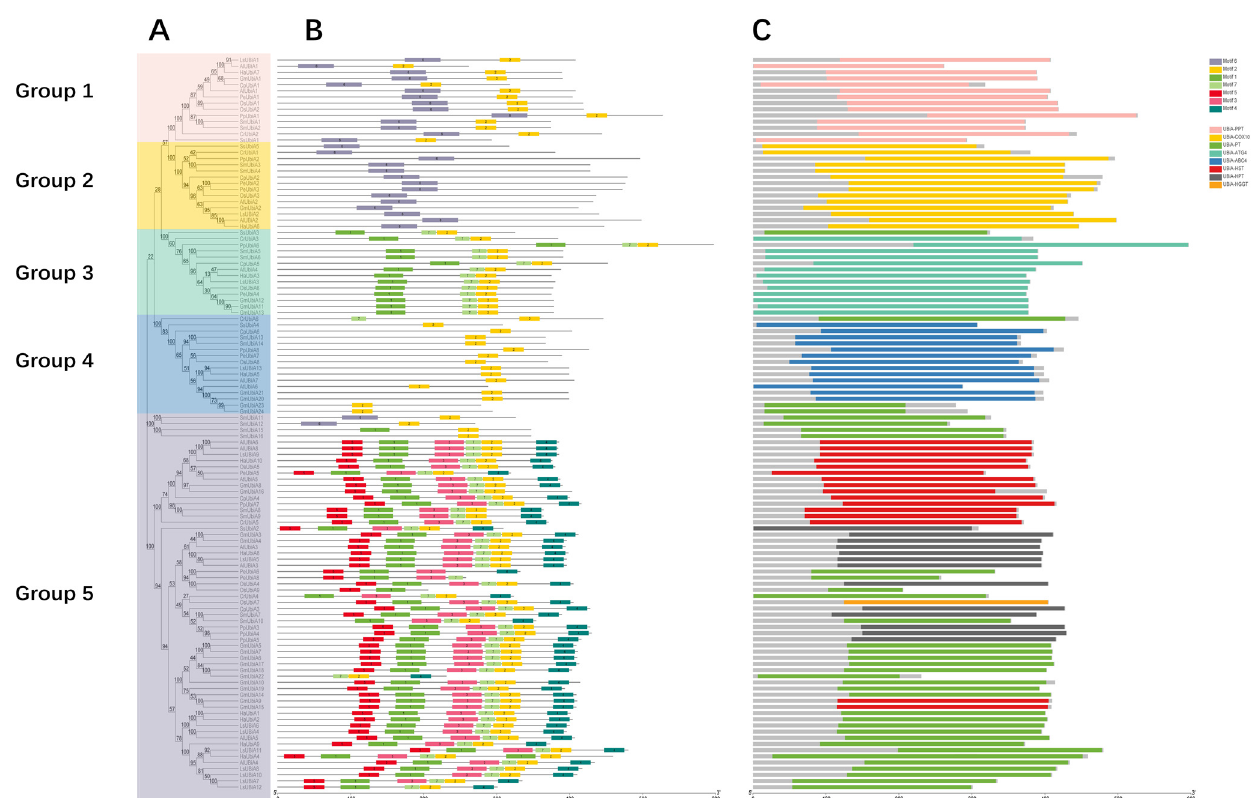
Figure 3. Conserved motifs and protein domain in 119 UBiAs. ( A ) Phylogenetic tree of UBiAs family members. ( B ) Conserved motifs of UBiA proteins. Seven conservative motifs of UBiAs were identified by using the MEME online tool. Each motif in UBiA proteins was represented with different colors. ( C ) Conserved domains of UBiA proteins. A total of eight protein domains were identified using NCBI conserved domain database and displayed in different